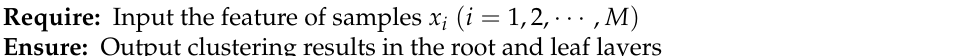
Algorithm 1 Algorithm of the hierarchical SOM